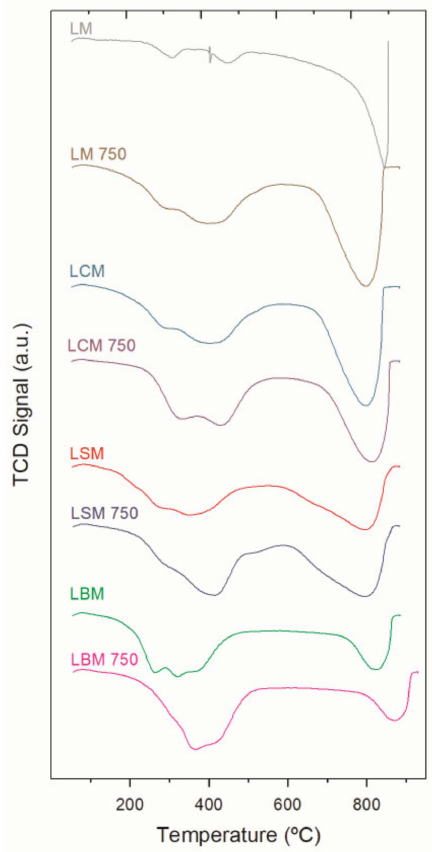
Figure 5. H 2 -TPR curves of the studied samples. Table 2. Reducibility of perovskite